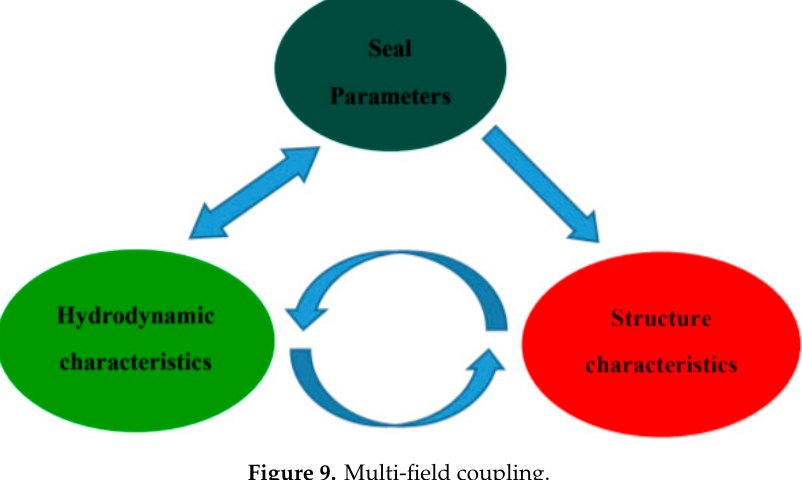
Figure 9. Multi-field coupling. Table 1. Calculation of fluid film parameters with different number of grids.